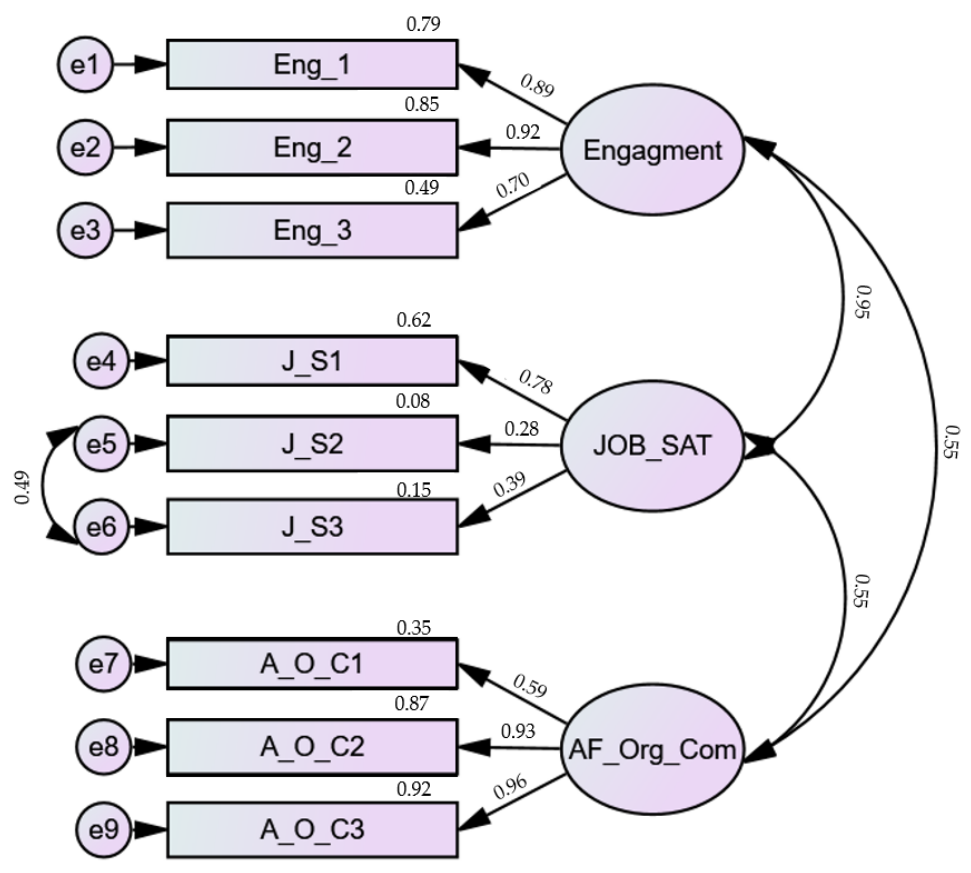
Figure 1. Final model of shorted happiness at work scale with a sample of Portuguese nurses.